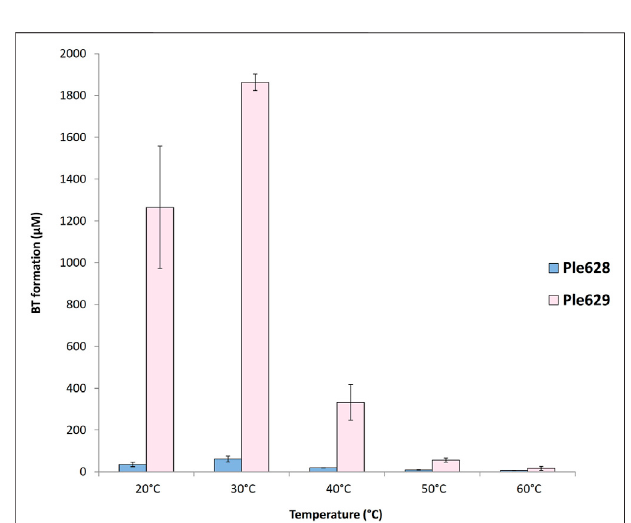
FIGURE 3 | Ples temperature optimum of incubation. Formation of BT (in µM) after degradation of ecovio ® FT by Ple628 and Ple629. Ple628 and Ple629 are shown in blue and pink, respectively. The tested temperatures were 20, 30, 40, 50, and 60 ° C. The error bars indicate the standard deviation ( n =